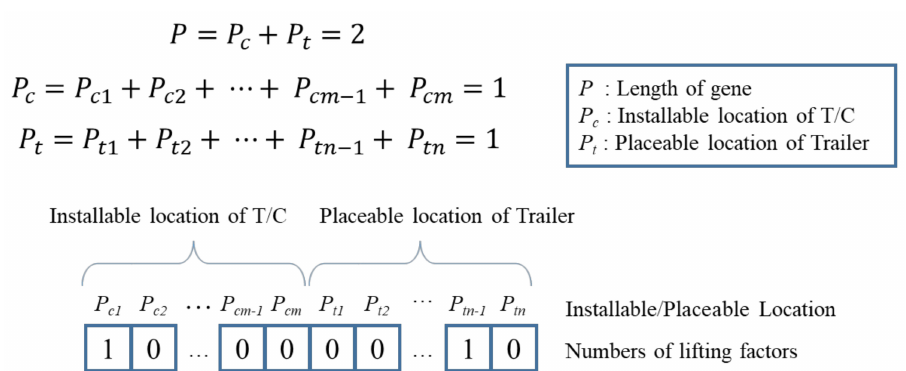
Figure 4. Definition of chromosome